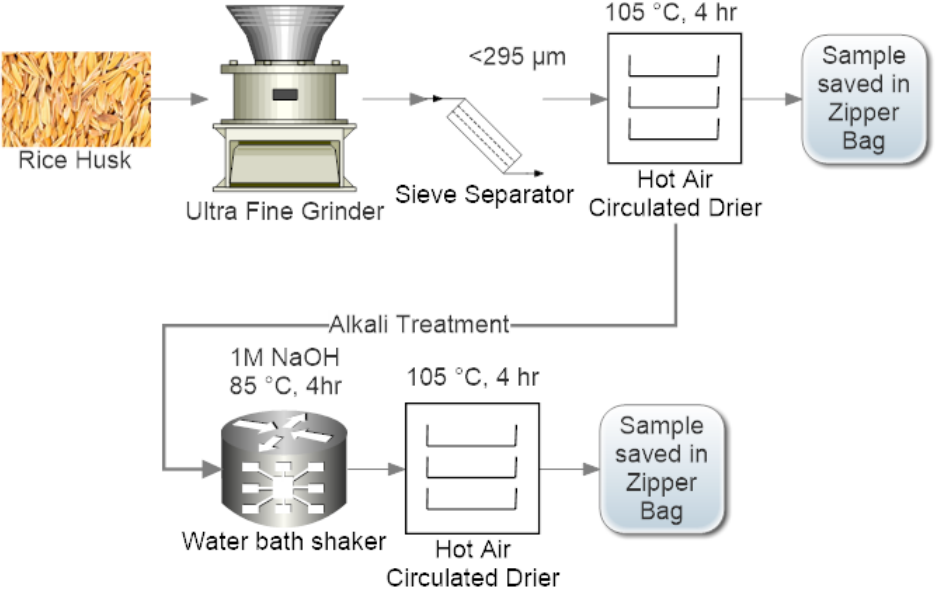
Figure 1. Biowaste rice husk pretreatment (untreated: top sequence, treated: bottom sequence).